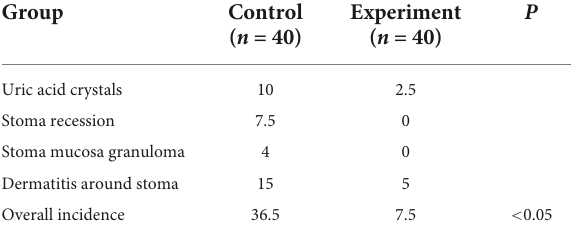
P Experiment ( n = 40) ( n = 40)